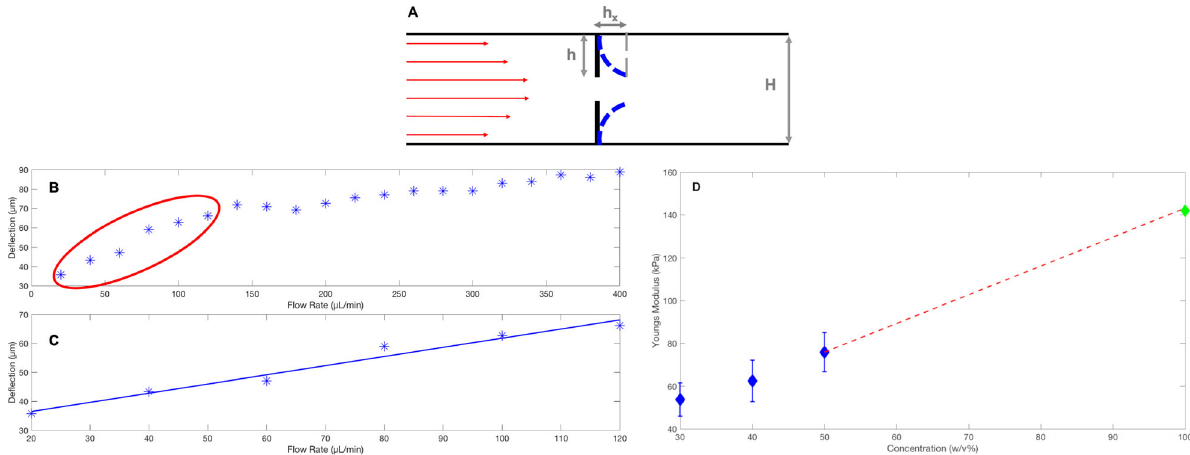
Fig. 7 In situ Young ’ s modulus evaluation. a A schematic diagram of how the de fl ection, h x is measured. b The de fl ections measured for different fl ow rates. c Zoomed in of the circled region in panel b designating the small linear de fl ection ( fi rst six points) which is used to calculate the Young ’ s modulus in plot D. Panel b and c refer to the case of 50% PEGDA concentration. The data shown in panel d refers to a fi xed concentration of PI equal to 4% (w/v). The error bars represent standard